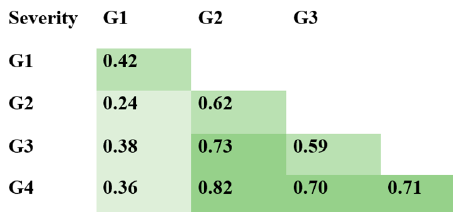
Figure 4. Correlation matrix for anti-N protein IgG subclasses and illness severity, analyzed by Spearman correlation coefficient. Darker shades of green represent more solid correlation: 0.2–0.39—weak correlation; 0.4–0.69—fair correlation; 0.7–1.0—solid correlation. p -value for all presented coefficients < 0.0001.